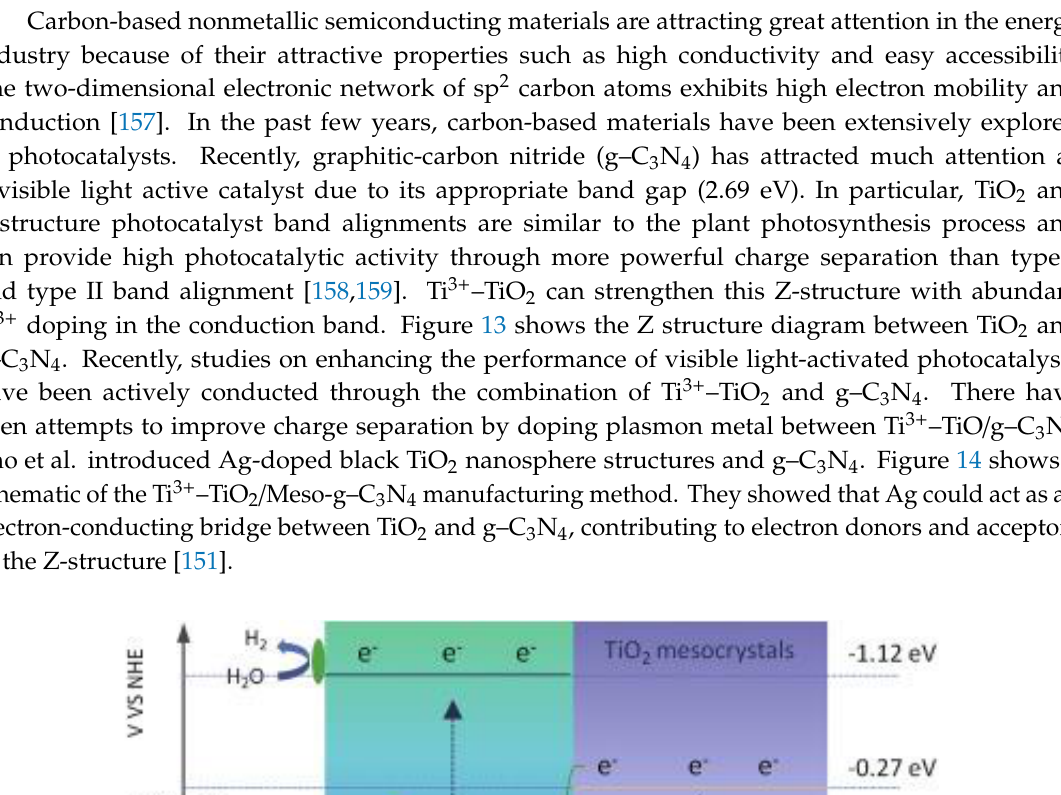
Figure 14. Energy diagrams of Ti 3+ –TiO 2 /Meso-g–C 3 N 4 nanosheet heterojunctions. Reproduced from [94] . Copyright (2017), Elsevier. 3.3.3. Metal Oxide/Ti 3+ –TiO 2 Heterojunctions of metal oxide and TiO 2 are a classic (and the easiest) method to enhance TiO 2 photocatalytic activity after metal doping. To date, new heterojunctions of various metal oxides and TiO 2 have been studied. Heterojunctions of Ti 3+ –TiO 2 and metal oxides are also of great interest. Although many metal oxides are candidates, heterojunctions of WO 3 and Ti 3+ –TiO 2 have recently been developed. WO 3 can achieve Z-structure band alignment with Ti 3+ –TiO 2 . The resulting Z- structure has a band structure similar to natural photosynthesis [158,159]. This can strongly increase the charge separation efficiency. In addition, two different redox sites can suppress the reverse reaction of radical production. In 2020, Nguyen et al. developed a catalyst that introduced blue Ti 3+ – TiO 2 and WO 3 produced by lithium (Li–EDA) of ethylenediamine, a strong reducing agent of the previous superbase. They show 100% selectivity in reducing CO 2 to CO, and that blue Ti 3+ –TiO 2 /WO 3 formed a perfect Z-structure (Figure 15) [91]. Consequently, the introduction of a complete Z- structure can be a powerful modification of Ti 3+ –TiO 2 . This is a direct way to overcome the weakness of charge separation and recombination and dramatically enhance the performance of photocatalysts.